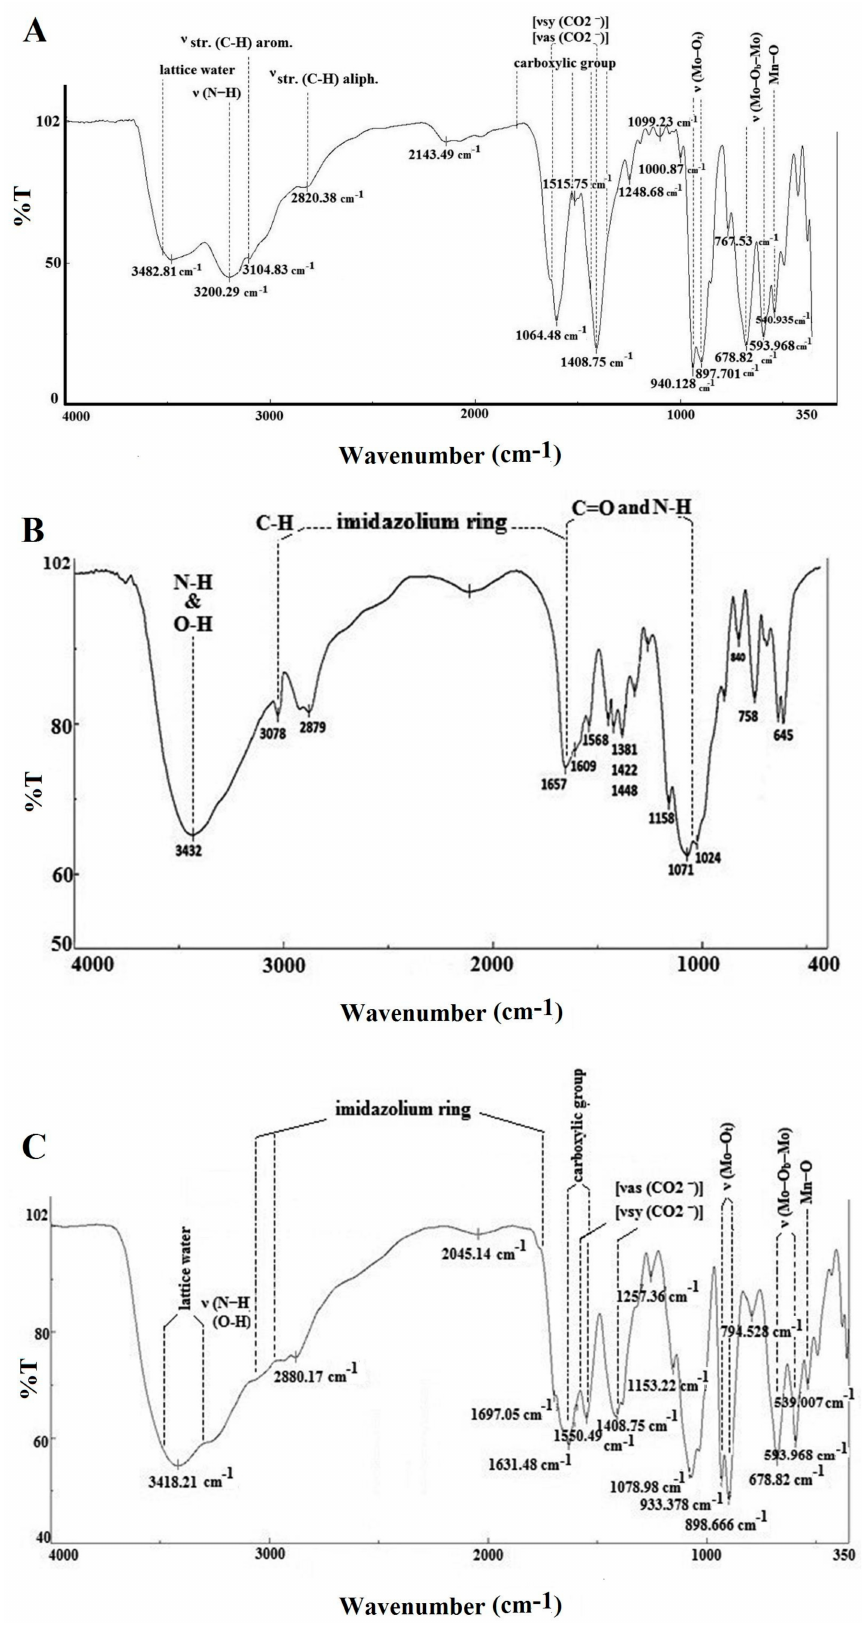
Figure 1. ( A ) FTIR results of POM, ( B ) FTIR of CSIm shell, and ( C ) FTIR of